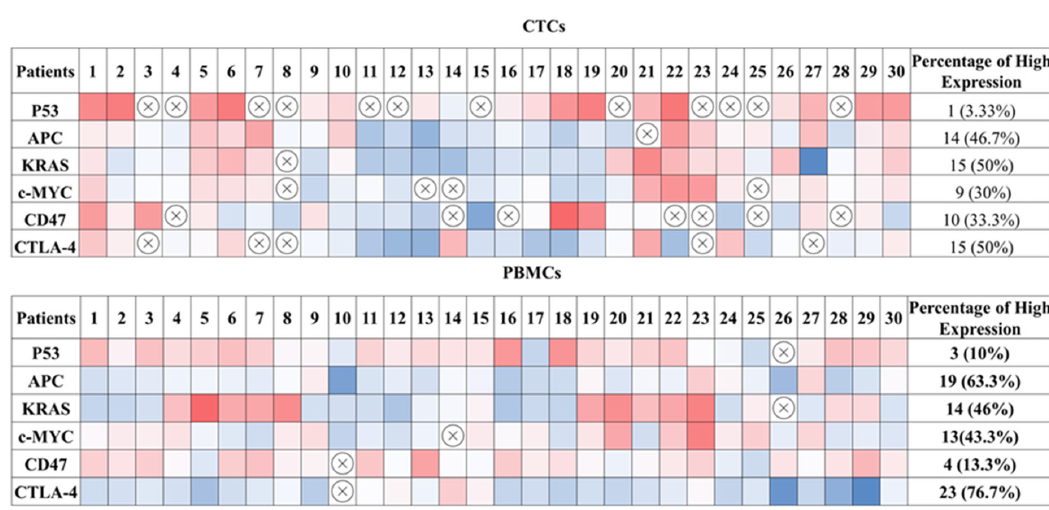
Figure 6. Heat map depicting the mRNA expression level and percentage of positive expression of the tumour suppressor genes p53 and APC ; the oncogenes, KRAS and c-Myc ; and the immune-regulatory molecules CD47 and CTLA-4 in CTCs and PBMCs among individual patients. The values were calculated from the log2 value of the relative quantification of each gene. The colour indicates the expression level for each gene. Red fields represent downregulated genes; blue fields represent upregulated genes; crossed ‐ out fields represent no expression.